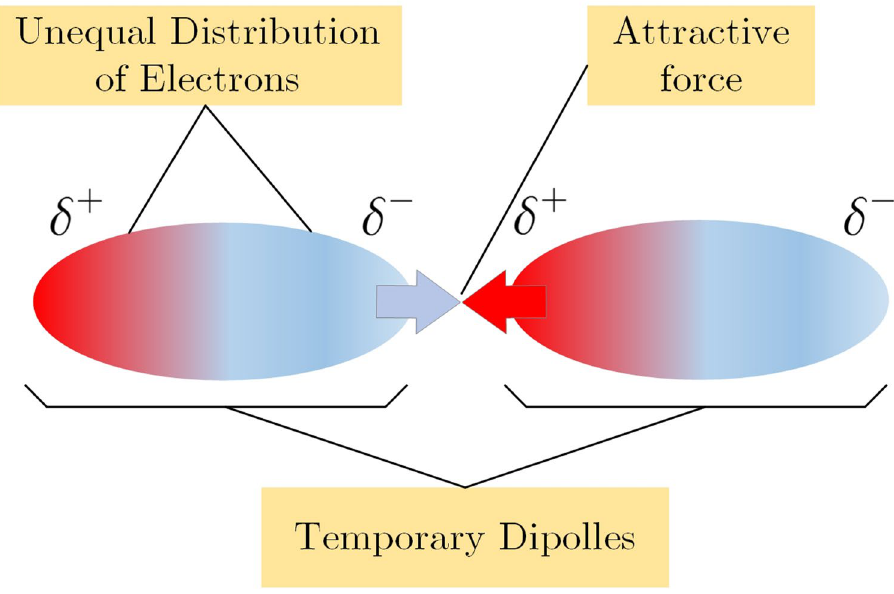
Figure 12. A schematic of the VDW force between temporary